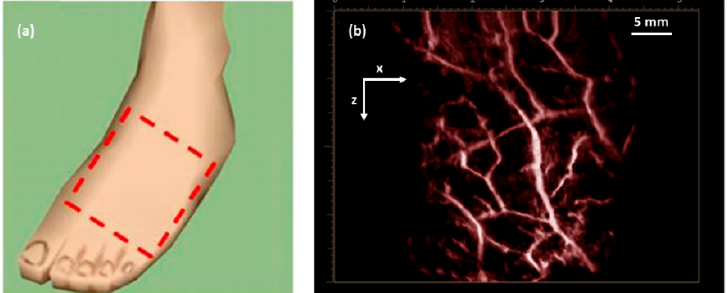
Figure 10. ( a ) Dashed box showing the imaging area on a human volunteer’s foot dorsum; ( b ) 3D maximum intensity projection PA image of the area marked in ( a ), clearly visualizing the vasculature network. Adapted with permission from. Reprinted with permission from Clinical Translation of